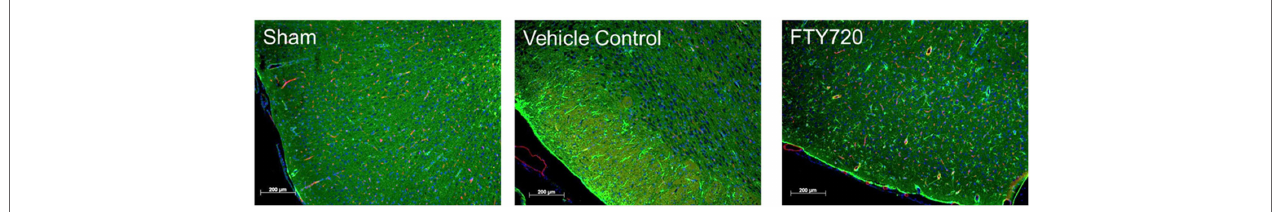
FiGUre 2 | effect of fingolimod (Fty720) on cerebral ischemia/reperfusion-associated astrogliosis . Male adult Sprague-Dawley rats were subjected to middle cerebral artery occlusion (MCAo) for 60 min followed by reperfusion as previously described (45). Three hours after reperfusion, animals were treated with vehicle or 0.5 mg/kg FTY720 intraperitoneally. Brains were harvested at 48 h after surgery, fixed in paraformaldehyde, and mounted to slides. Immunofluorescence staining was performed using anti-glial fibrillary acidic protein antibody (astrocytes; green), anti-endothelial barrier antigen antibody (endothelial cells; red), and DAPI (nuclei; blue) (bar: 200 μ m). Representative images obtained for sham, MCAo-vehicle control, and MCAo-FTY720 animals ( n = 5 per group). A marked increase in astrogliosis was observed in the MCAo-vehicle group, and this was markedly ameliorated in MCAo-FTY720-treated animals.